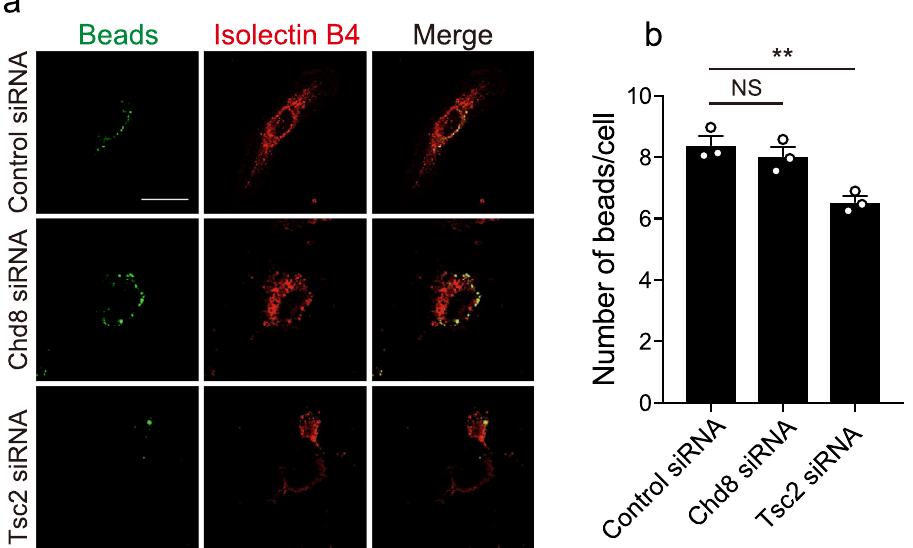
Figure 2. The deficiency in the expression of Tsc2 affects phagocytosis activity in primary microglia. ( a ) Primary microglia transduced siRNA were treated with fluorescent beads (green) to assess phagocytosis. After 24 h, microglia were stained with isolectin B4 (red). Scale bar: 20 μm. ( b ) A graph showing the number of beads in isolectin B4 + microglia (n = 3, biologically independent experiments, F (2, 6) = 13.63, df = 6, p = 0.0059 for main effect of group, p = 0.6335 for control siRNA vs. Chd8 siRNA, p = 0.0064 for control siRNA vs. Tsc2 siRNA assessed by one-way ANOVA, followed by Tukey–Kramer tests). NS not significant, ** p < 0.01. Error bars represent mean ±